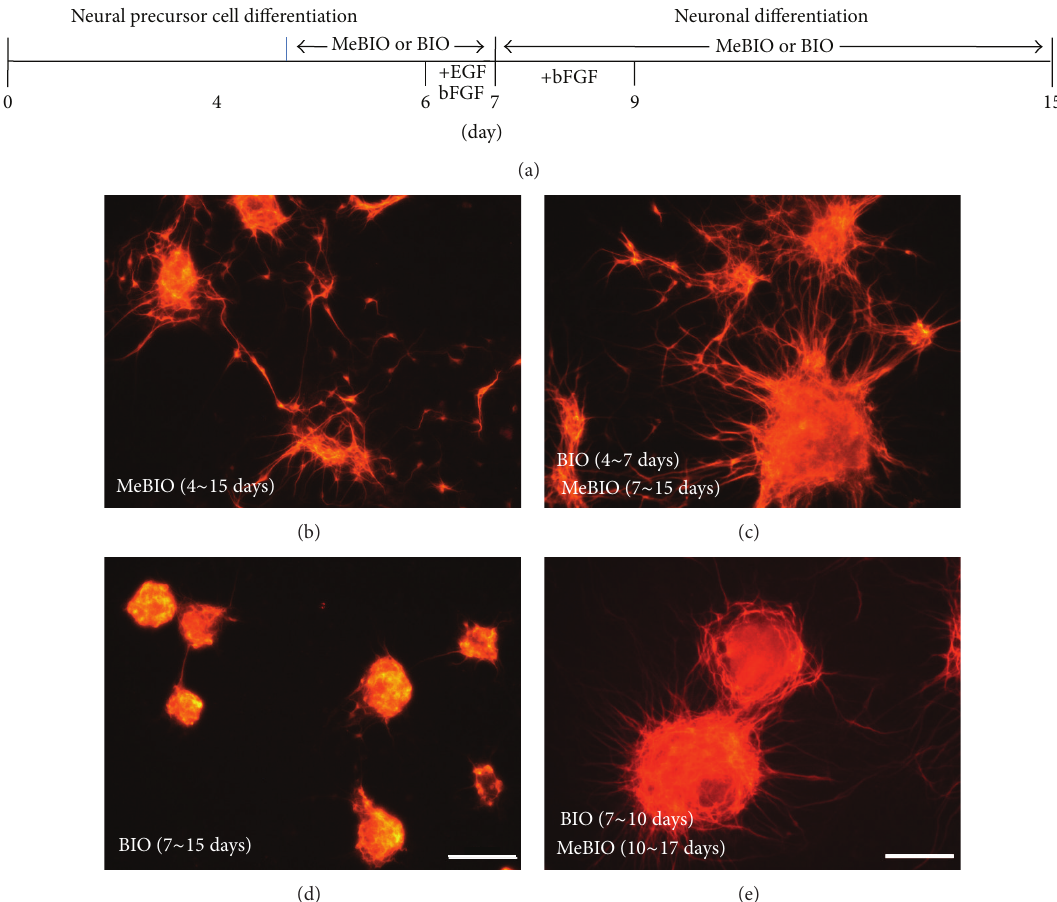
Figure 4: Inhibition of neurite formation during late neuronal differentiation by GSK3 𝛽 inhibitor. (a) Diagram of MeBIO (0.75 𝜇 M) or BIO (0.75 𝜇 M) treatment during late neuronal differentiation of 46C ES cells. (b)–(e) Cells cultured according to the diagram for 15 days were stained with MAPII antibody. Neurite formation was elevated by BIO treatment from days 4 to 7 (c), whereas it was reduced by BIO treatment from days 4 to 15 (d). (e) Cells were cultured with BIO from days 7 to 10 and cultured with MeBIO for 7 days after replating, followed by staining with MAPII antibody. Scale bars, 100 𝜇